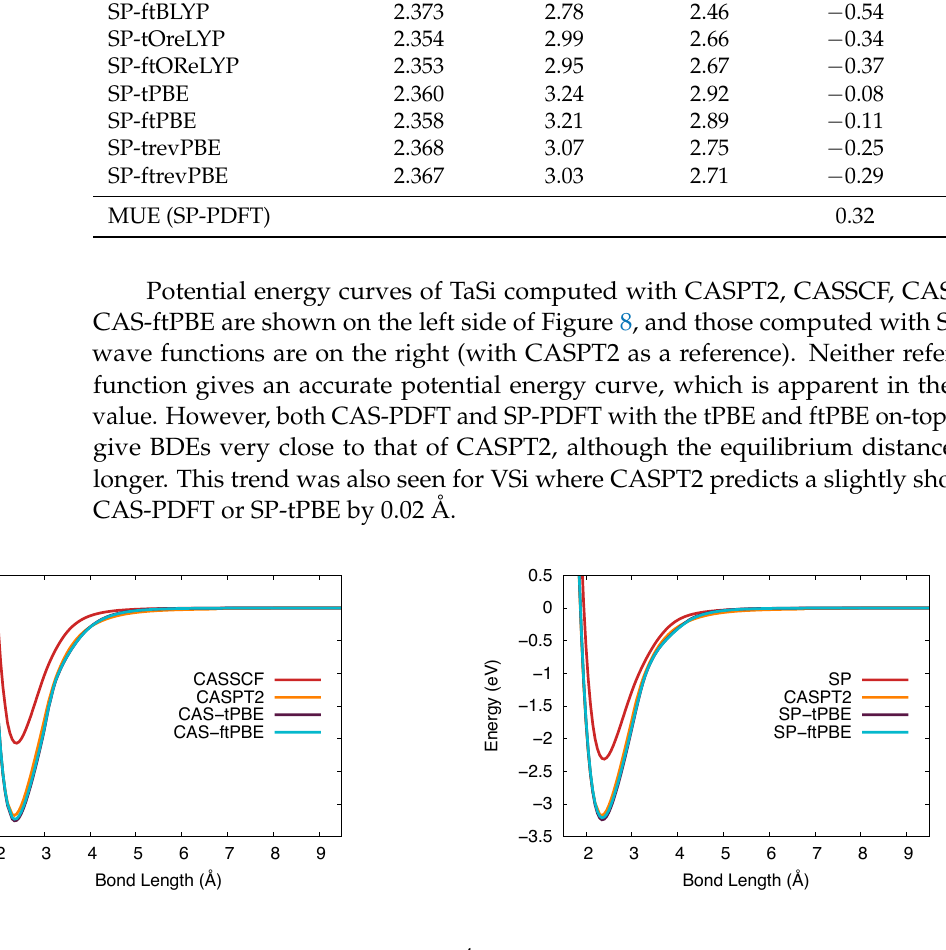
Figure 8. The potential energy curve for tantalum silicide in the 4 Π ground state. ( Left ): Computed with CASSCF (red), CASPT2 (orange), CAS-tPBE (purple), CAS-ftPBE (blue) with a (7,10) active space. ( Right ): Computed with SP (red), SP-tPBE (purple), SP-ftPBE (blue) with a GAS5(7,10) active space. CASPT2 (orange) is included for